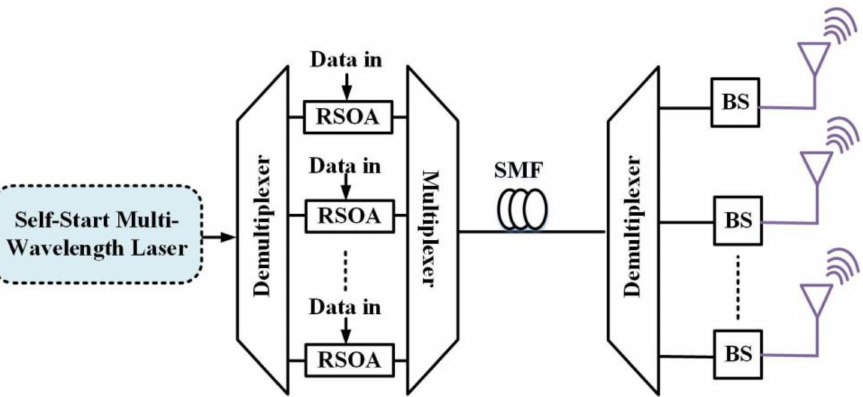
Figure 1. Schematic illustration of the self-start multi-wavelength laser for RoF transport systems for wireless applications (RSOA: reflective semiconductor optical amplifier, BS: base station, and SMF: single-mode